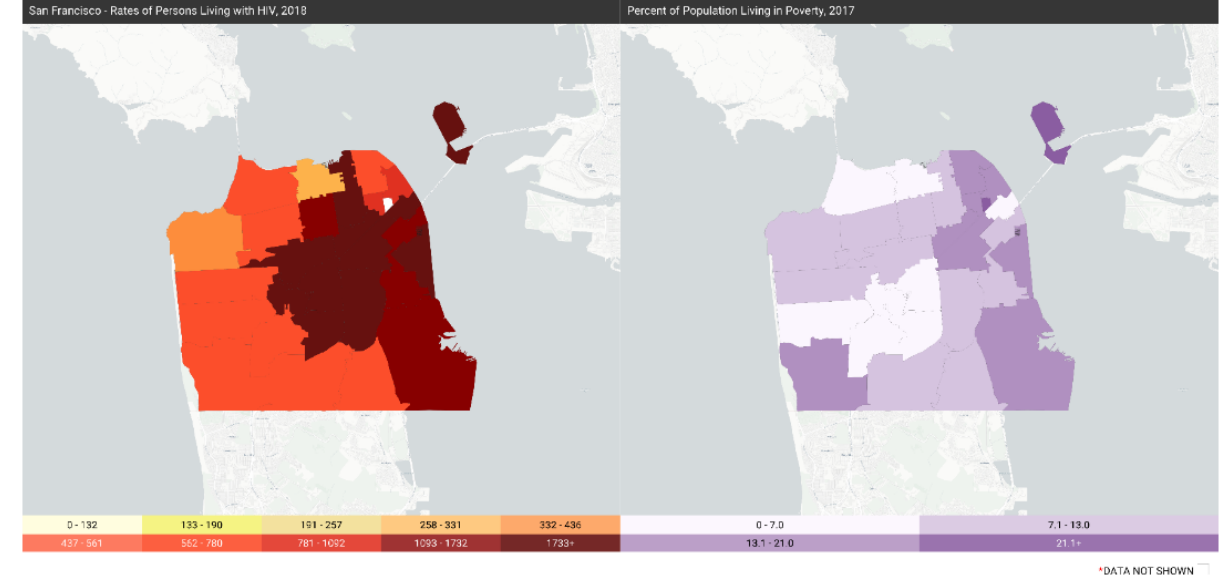
Figure 7. Percent of population living in poverty, San